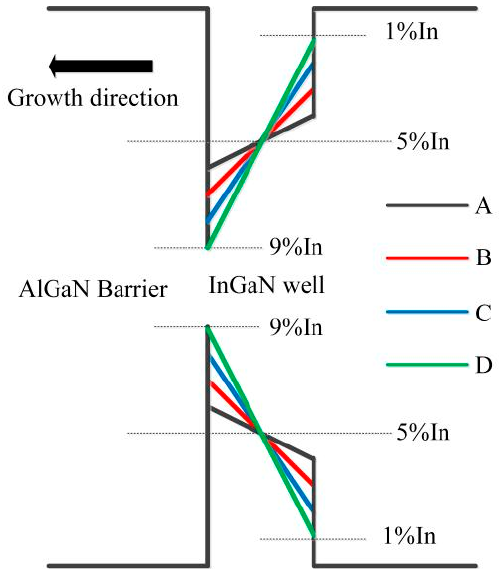
Figure 1. Schematic diagrams of energy bands of InGaN QW with different In gradients for samples A , B , C and D . The polarization effect is not considered here for simplification.